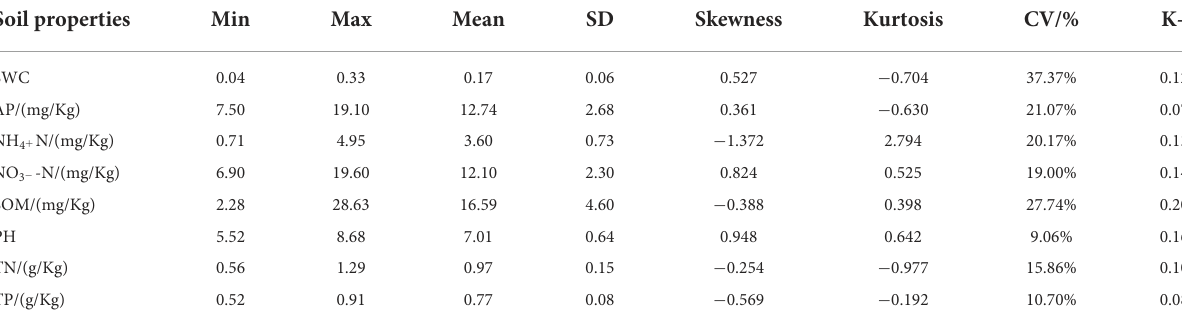
TABLE 2 Descriptive statistics of soil environmental factors in the water level fluctuation zone of Three Gorges Reservoir. Soil